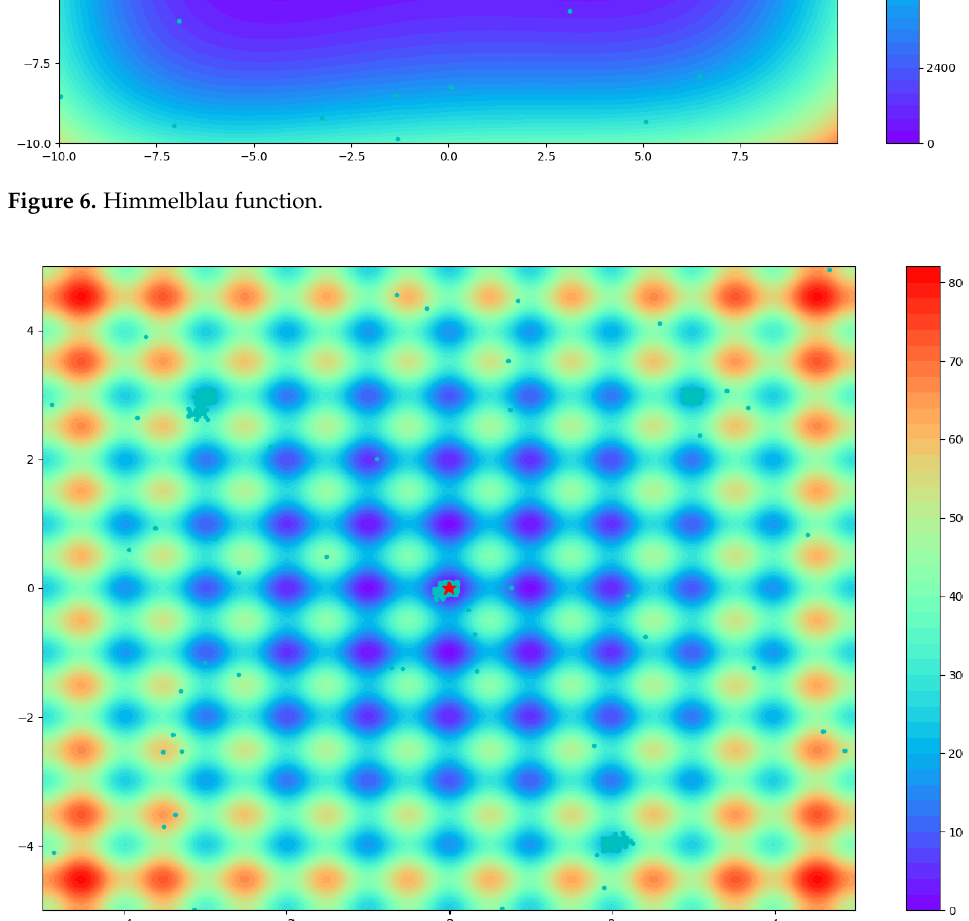
Figure 7. Rastrigin